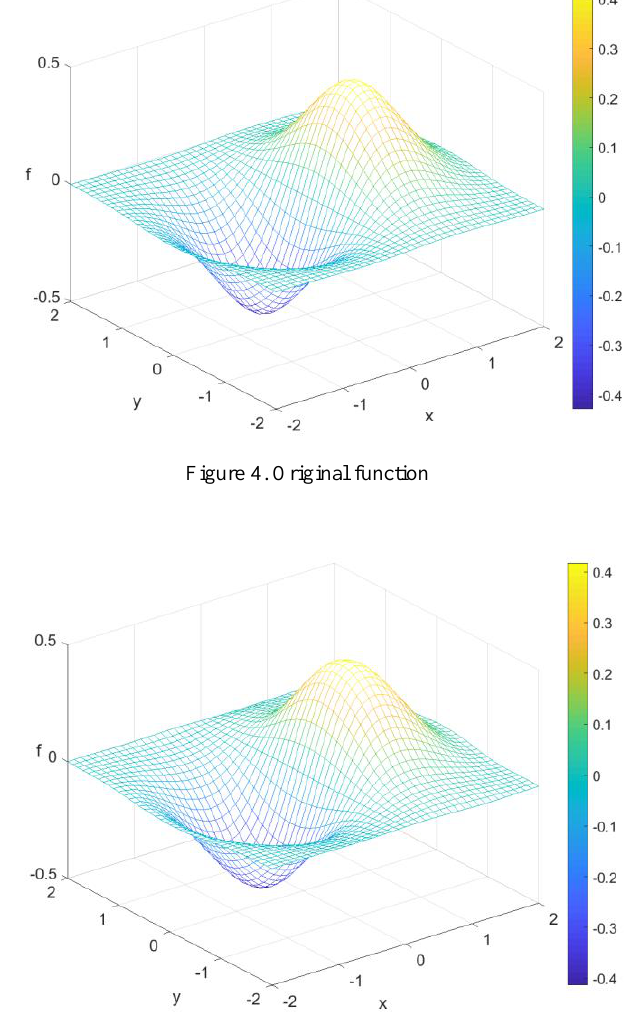
Figure 5. Fitted surface obtained from cubic least squares